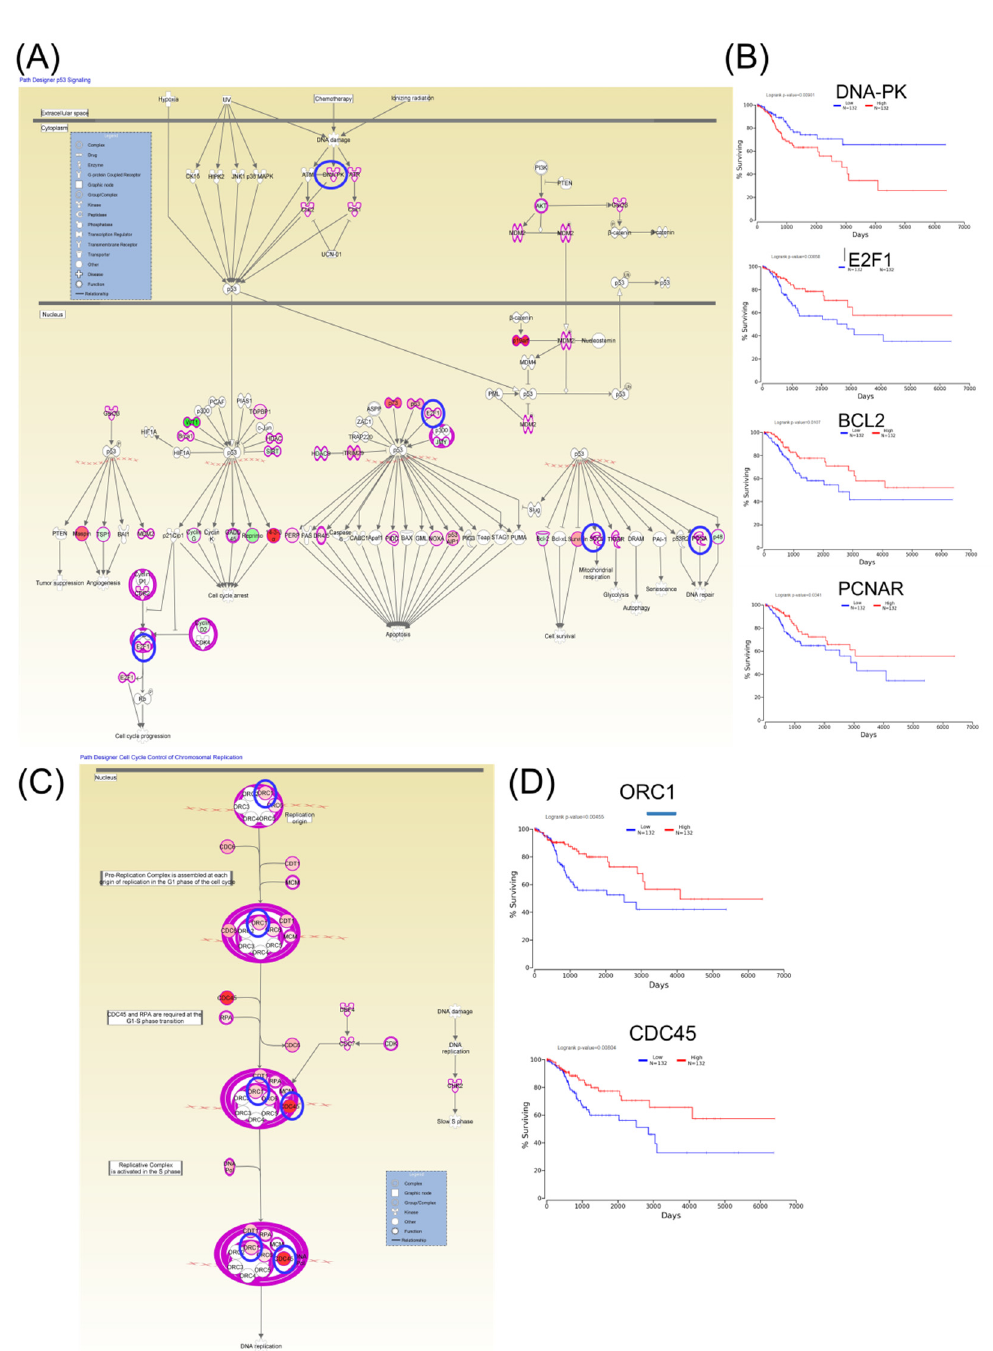
Figure 5. An IPA gene interconnected network based on altered genes in CC. ( A ) IPA generated networks focusing on altered genes in CC related to TP53 signaling. ( B ) Genes predicting overall survival related to TP53 signaling. ( C ) IPA generated networks focusing on altered genes in CC related to cell cycle control of chromosomal replication ( D ) Genes predicting overall survival related to cell cycle control of chromosomal replication; overexpressed genes are displayed in red, while downregulated are in green; blue circles are for genes predictin overall survial rate in CC